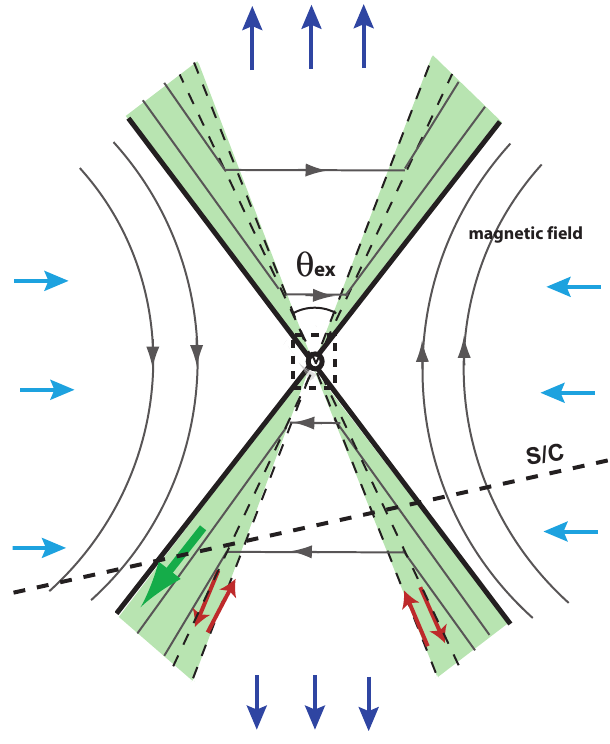
Fig. 1. Illustration of a reconnection region in the plane of recon- nection. Thick black lines show the separatrices and the dashed box outlines the X-line region. The green-hatched area depicts the sepa- ratrix region where the dashed lines bound the current sheets. Light (dark) blue arrows denote the plasma inflow (outflow). Green arrow shows the direction of the proton beam and the red arrows show the dominant directions of the electron flow during the current sheet